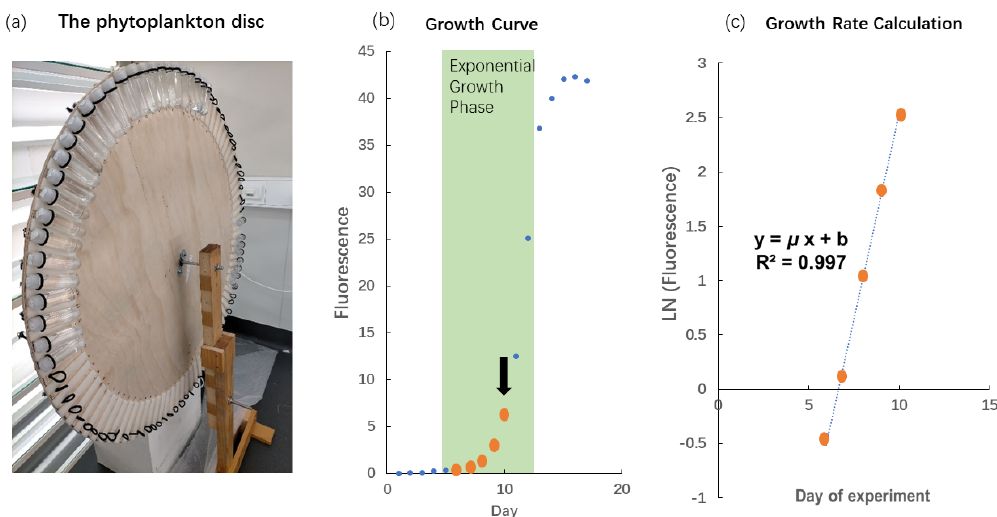
Figure 1. The phytoplankton disc and growth rate calculation. (a) The phytoplankton disc, with polycarbonate tubes mounted using elastic bands to the edge of the circular disc. The disc rotated at 0.8 revolutions per minute during the experiment. (b) In vivo chlorophyll fluorescence during the growth cycle of phytoplankton cultures, Phaeodactylum tricornutum (CS-29). We only used fluorescence values where biomass inside the polycarbonate tubes was still relatively low (maximum up to fluorescence of 6.1) as indicated in this example with the thick orange dots. The arrow indicates the time when the culture was usually transferred into the next batch of fresh medium. (Please note that the data illustrated here are from a test in which we let the culture grow into nutrient depletion.) (c) The fluorescence values measured at low biomass were ln transformed and plotted against time (day). The slope of the linear regression in this plot represents the specific growth rate ( µ ; d − 1